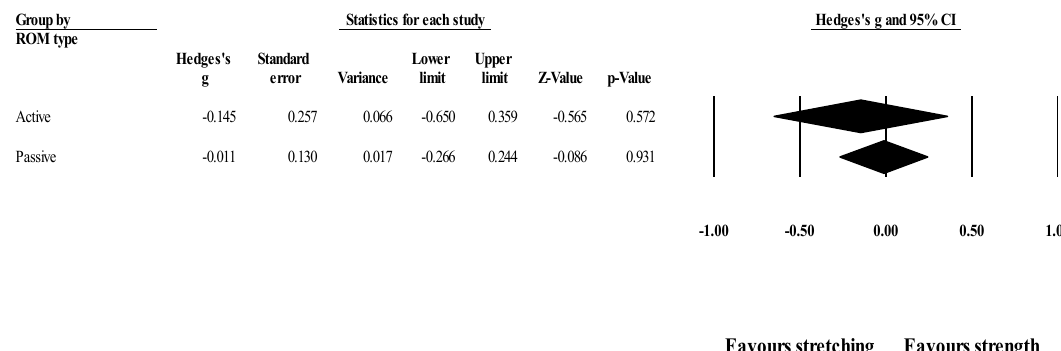
Figure 5. Forest plot of changes in ROM after participating in stretching-based compared to Scheme 95. confidence intervals (CI).